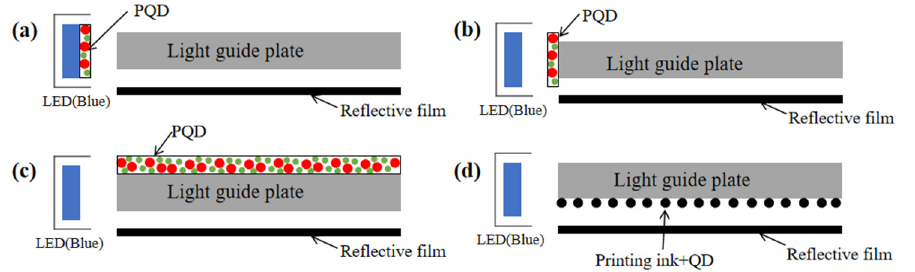
Figure 9. Schematic diagram of PQD backlight structures. ( a ) On chip; ( b ) on edge; ( c ) on surface; ( d ) in dot.